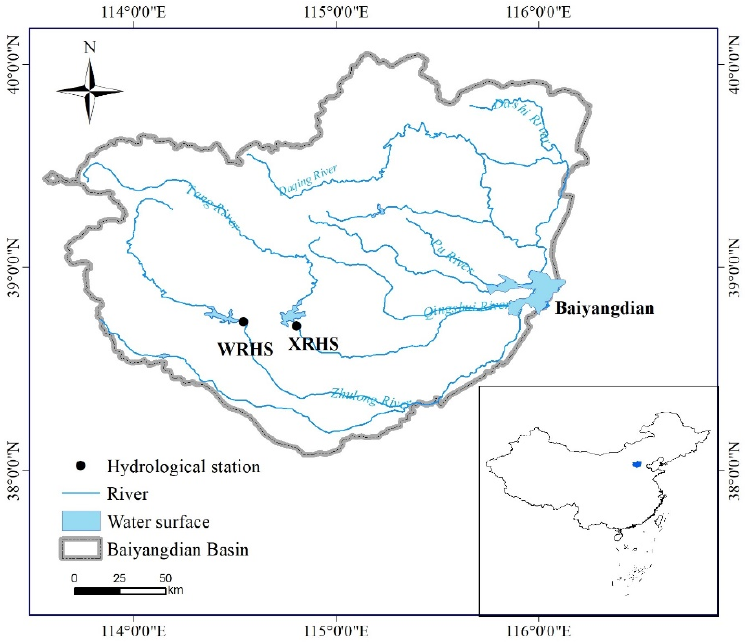
Figure 1. Map of the study area showing Lake Baiyangdian and the extent of the Baiyangdian Basin in China. Wangkuai Reservoir hydrological station (WRHS) and Xidayang Reservoir hydrological station (XRHS).